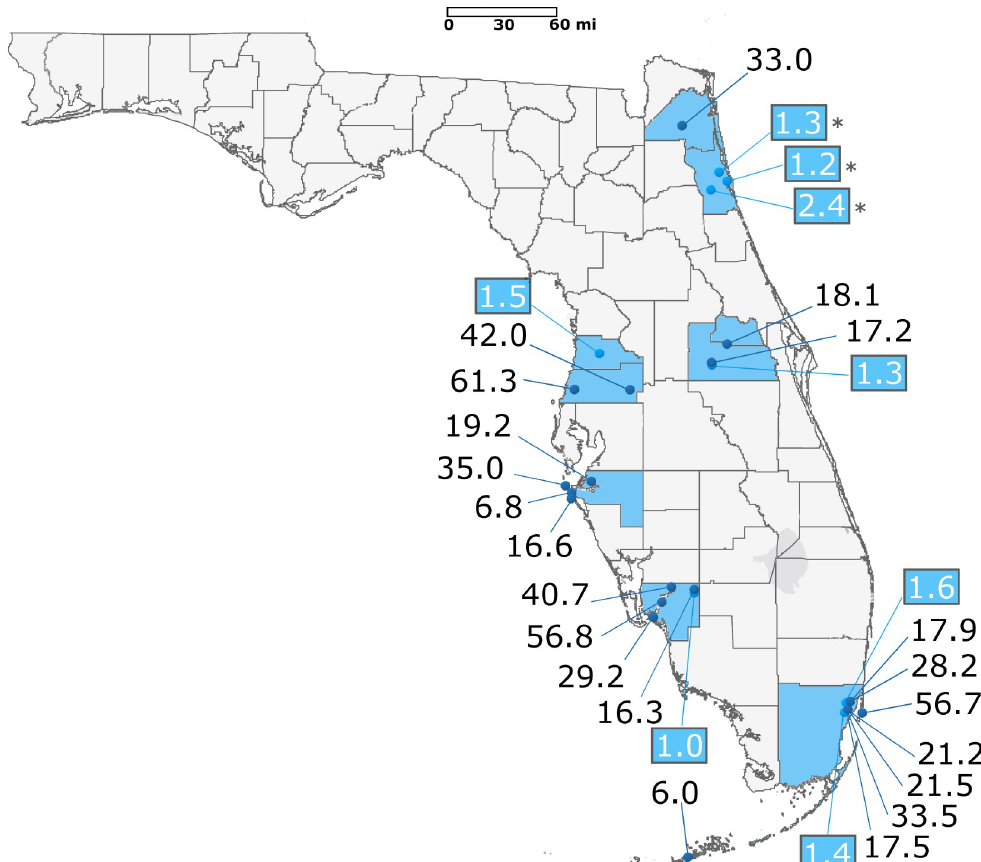
Fig 1. Permethrin resistance ratios of Ae . aegypti and Ae . albopictus (in blue) strains compared to the susceptible ORL1952 laboratory strain. The Ae . albopictus RR for St John’s County (marked with asterisks) are taken from our previous study [24]. Base maps were sourced from ESRI and Tele Atlas data through ArcGIS Online under an enterprise license with USDA. Additional layers were added to the base map using GIMP